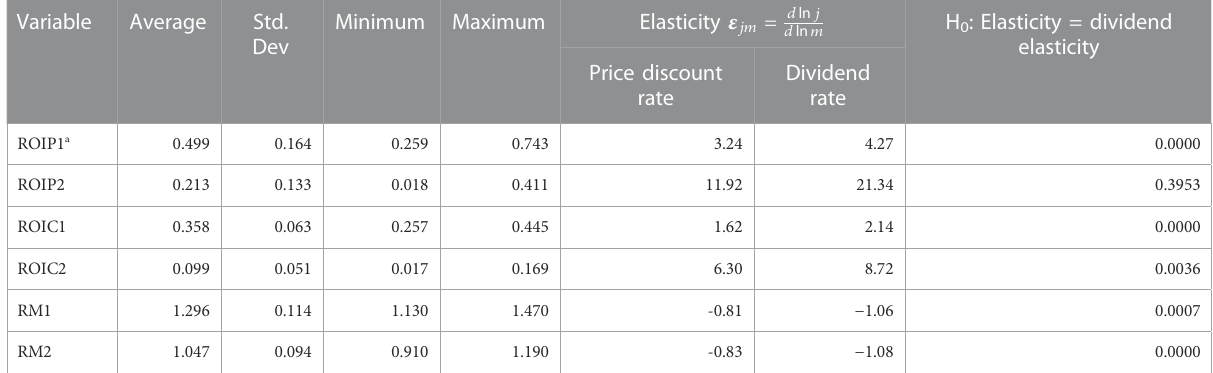
TABLE 7 Summary statistics for ROIP and ROIC results for sensitivity to changes in price discount rate and dividend rate under 100% equity fi nancing and higher ef fi ciency SOEC energy-to-ammonia technology (6.5 MWh/MT).